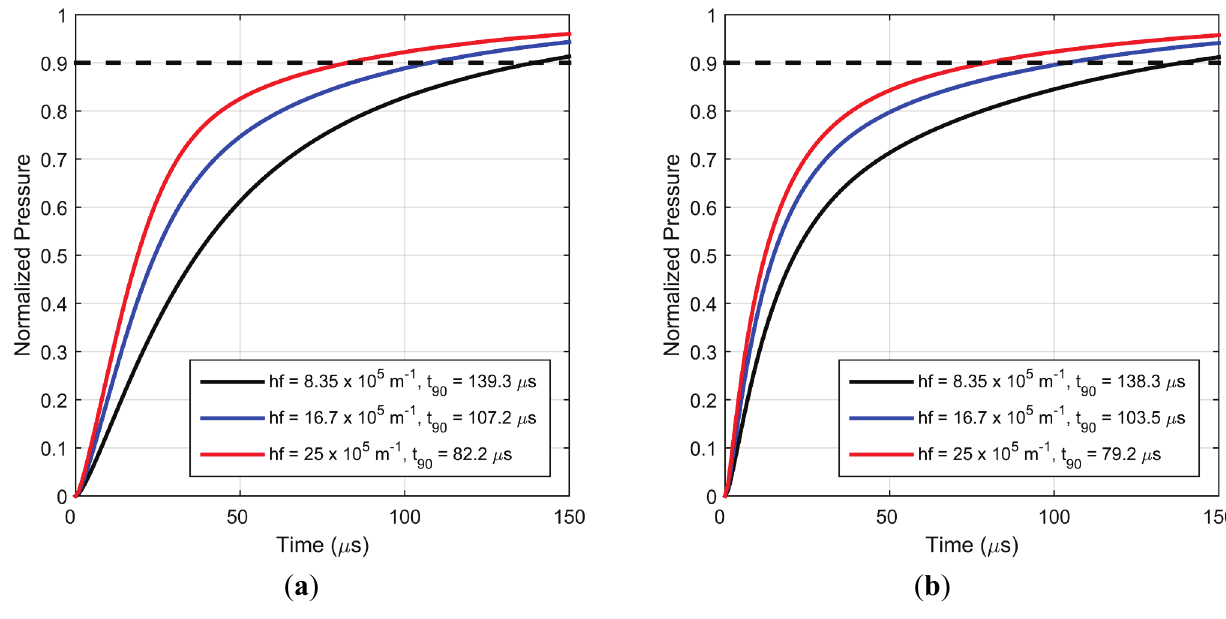
Figure 15. Simulated pressure response for ( a ) step increase in pressure from vacuum to 1 atm. and ( b ) step decrease in pressure from 1 atm. to vacuum, for different values of hiding